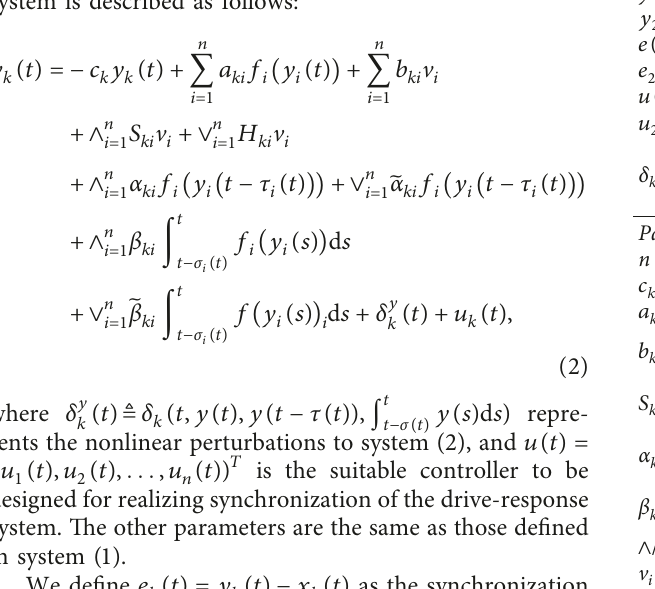
Table 1: The meanings of sets, parameters, and vectors. Meaning Set R The set of all the real numbers R + The set of all positive real numbers R n The set of all n -dimensional real vectors Vector x ( t ) � ( x ( t ) , The state vector of neurons in the 1